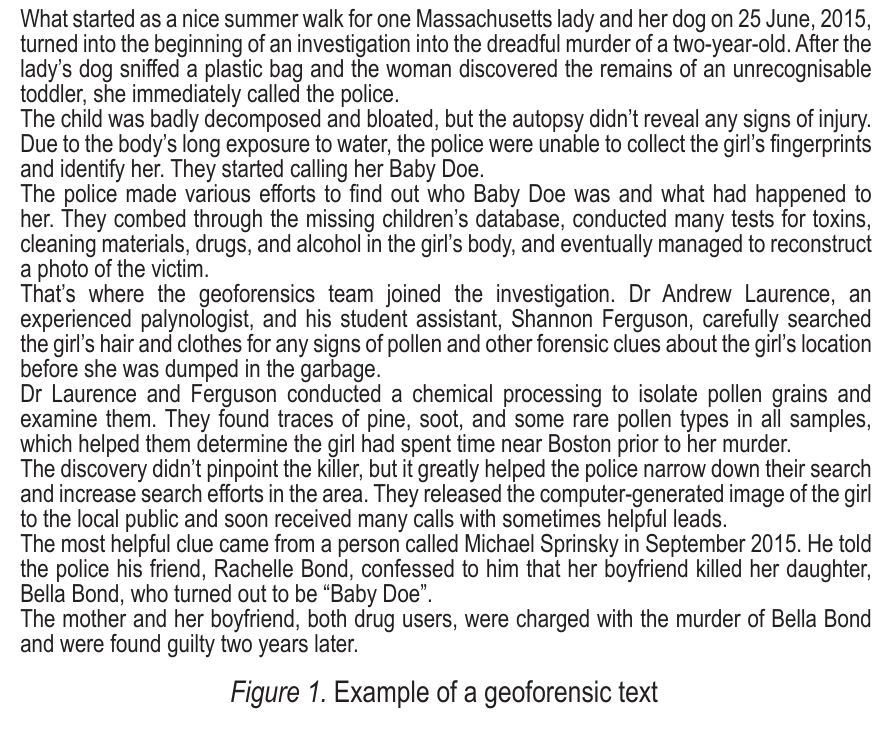
Figure 1. Example of a geoforensic text